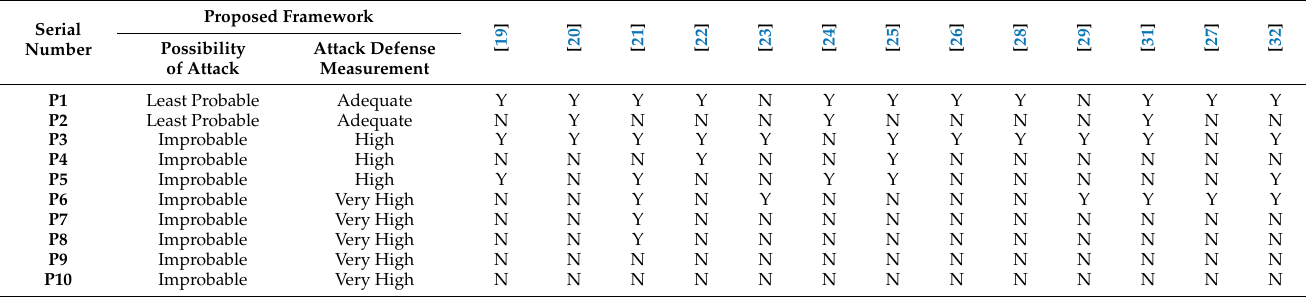
Table 6. Security Comparison of Proposed Framework with Related